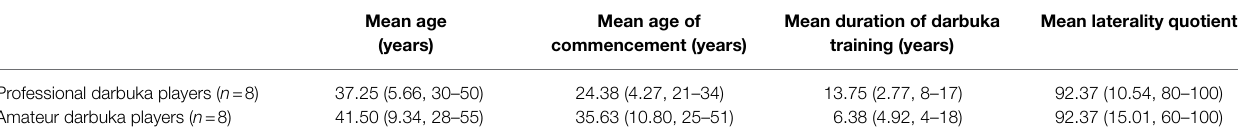
TABLE 1 | Age, age of commencement, handedness score for both groups (SD and range in